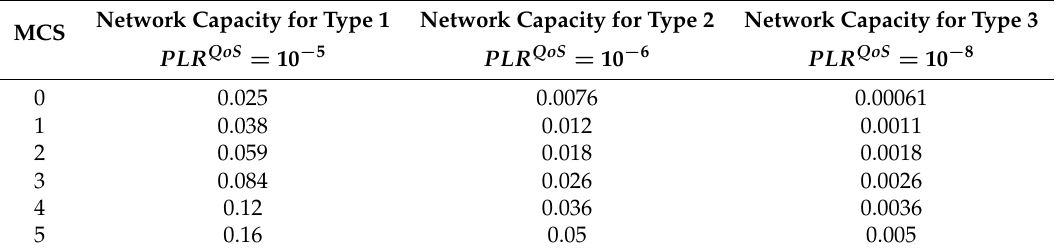
Table 2. Network capacity, frame per second, for various mote types and modulation and coding schemes